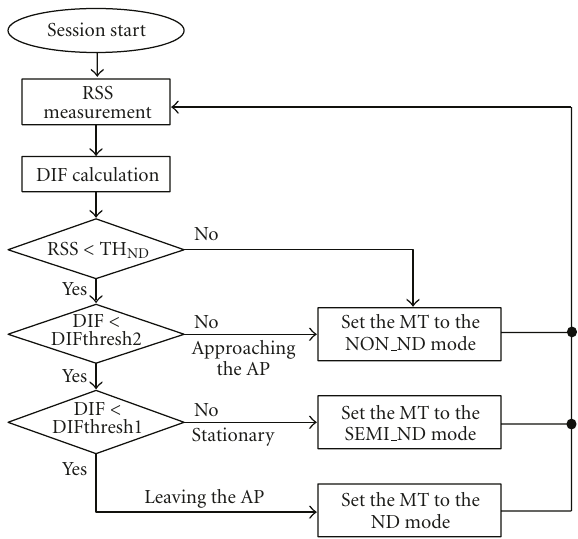
Figure 2: The NDMD algorithm for network discovery.